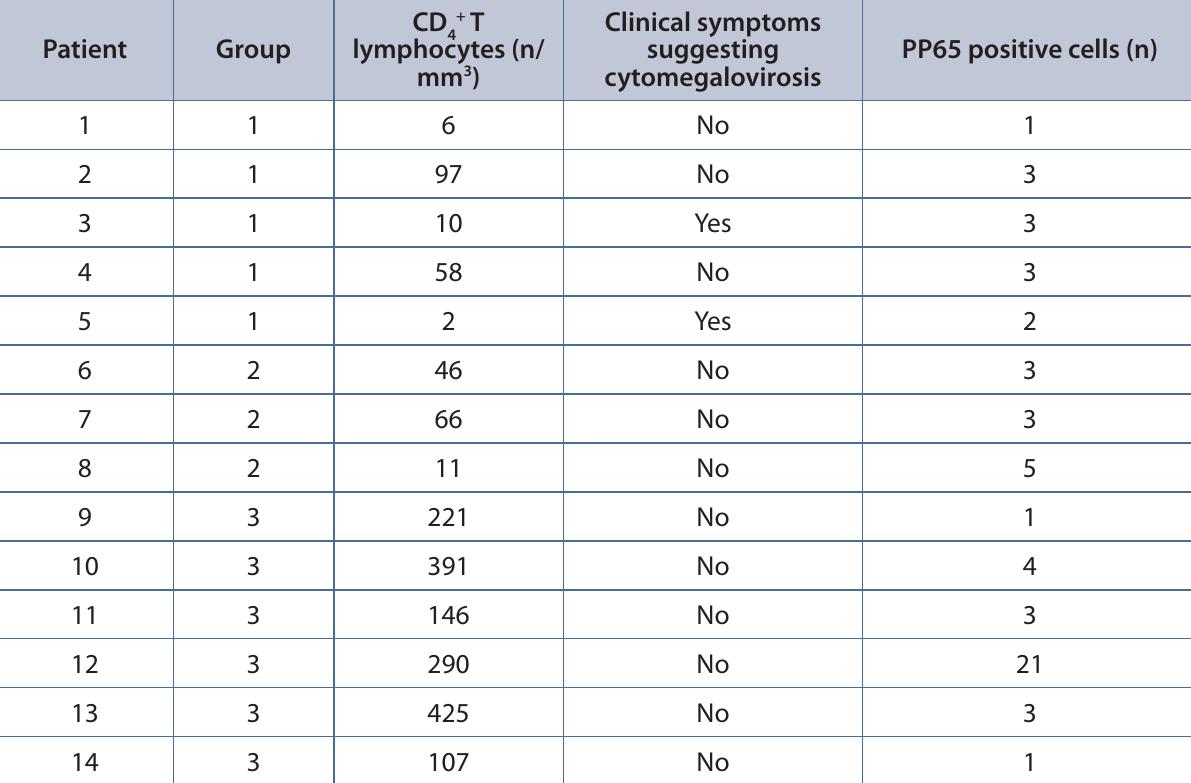
CD 4+ T Clinical symptoms lymphocytes (n/ suggesting PP65 positive cells mm 3 ) cytomegalovirosis